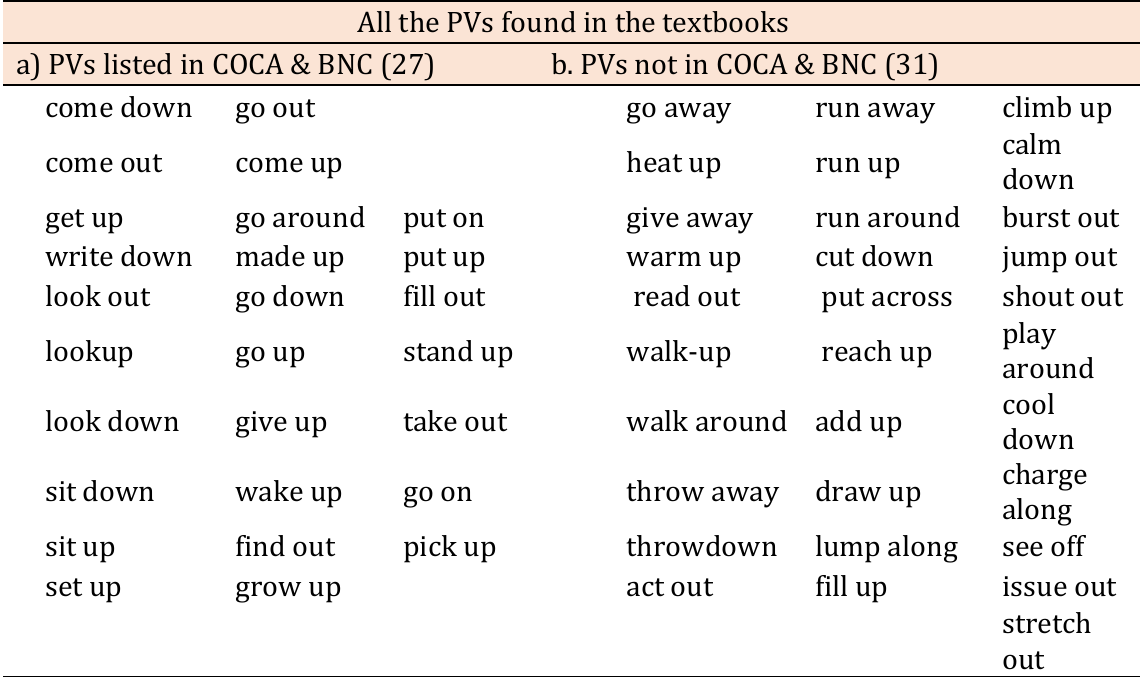
Table 4. The total PVs (58) in the current textbook corpus and their inclusion in two standard corpora All the PVs found in the